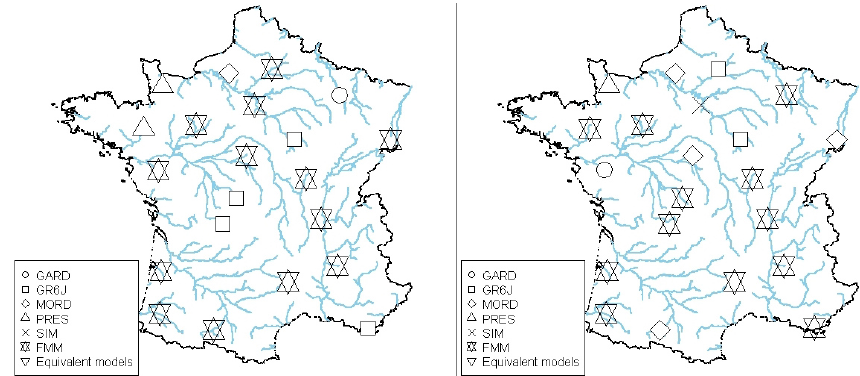
Figure 15. Maps of the model ranked best in simulation for the mean of all criteria and for validation periods 1 (left panel) and 2 (right panel), including the multi-model (fixed-weight average approach,